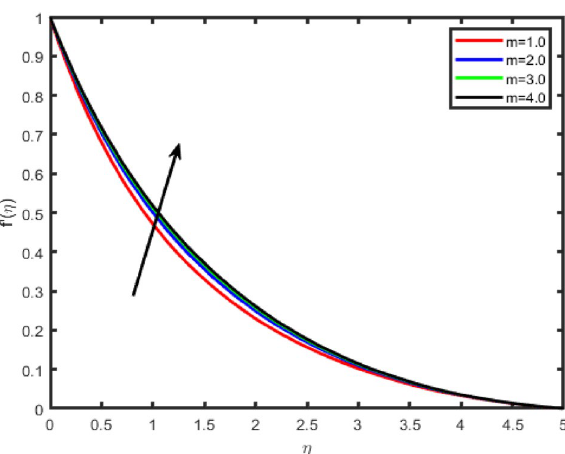
Figure 6. Effect of Hall parameter (m) on tangential velocity f ′ (η).